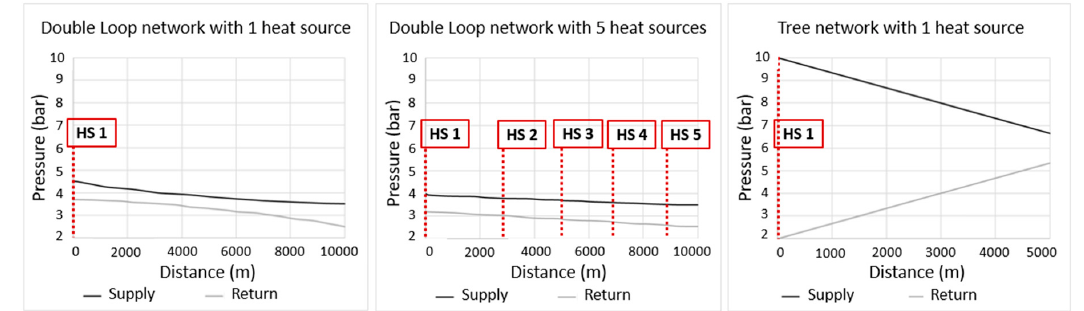
Figure 7. Comparison of pressure profiles for the double loop network (with one and five heat sources) and the tree networks. All cases’ hydraulics are at the design condition.